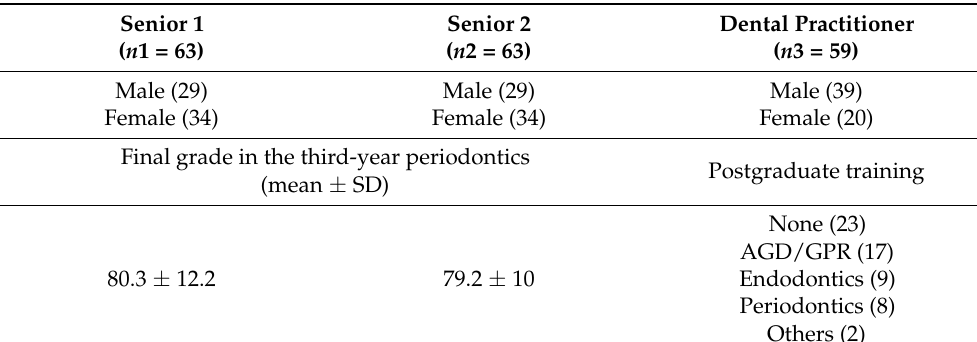
Table 2. Summary of the participants (the number of participants).